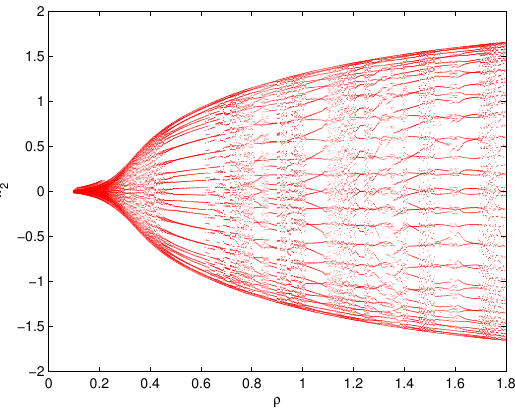
Figure 9. Bifurcation figure of system (96): ρ versus w 2 . The bifurcation value ρ (cid:63) ≈ 0.3.